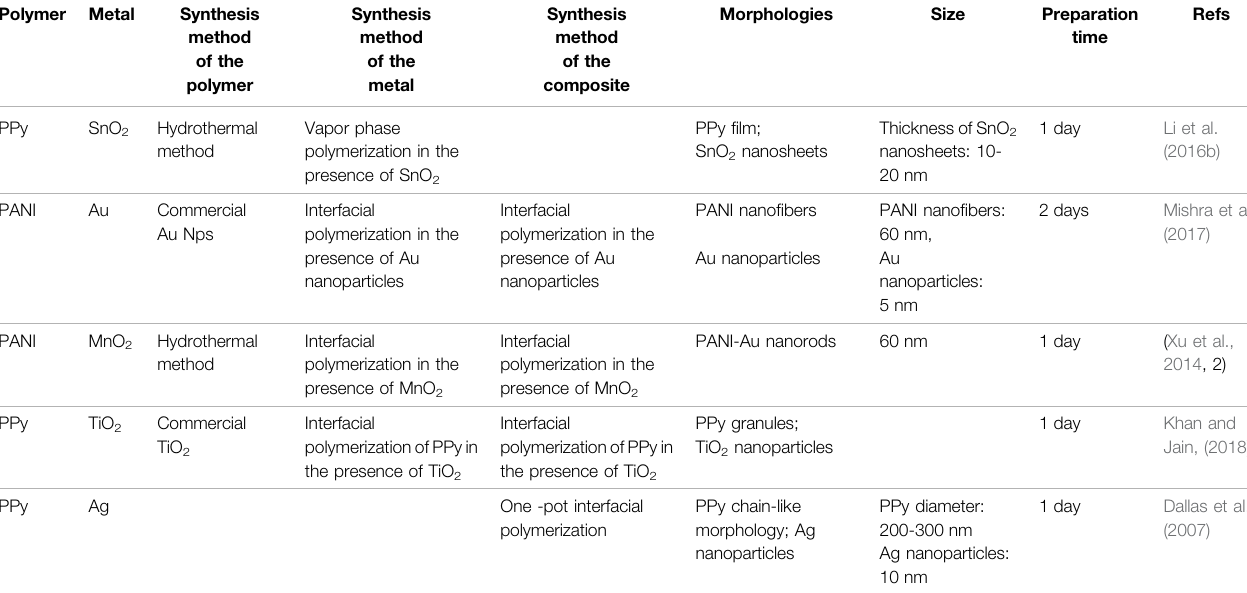
TABLE 1 | ( Continued ) Comparison of morphological structure and synthesis techniques of monometallic-based conducting polymers